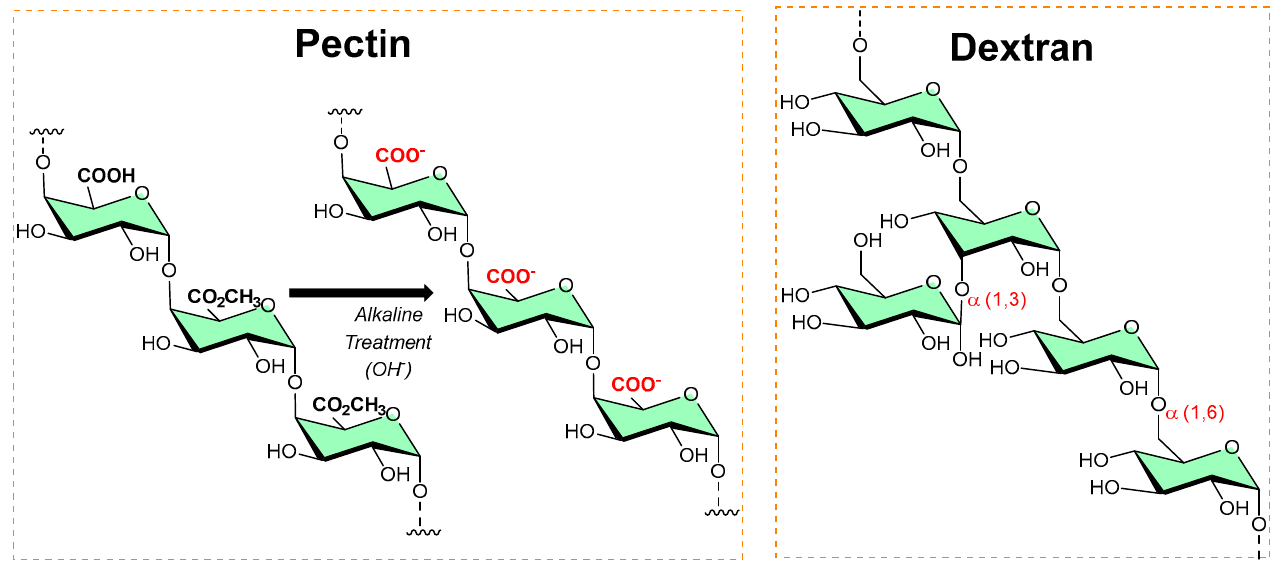
Figure 6. The typical chemical process of converting pectin into a more functional form, while the dextran structure shows alpha linkages and available functionalized sites.